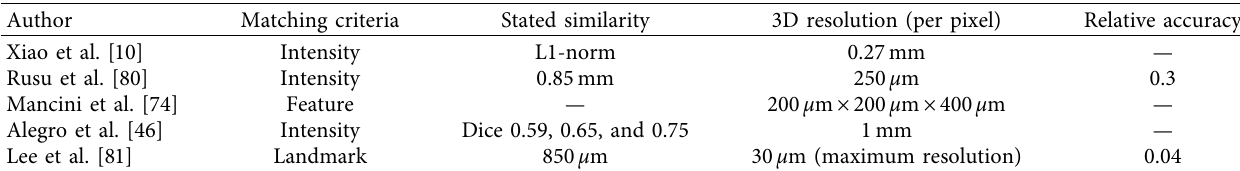
Table 3: List of volume-to-volume registration strategies discussed in this review. Due to a lack of information, a direct comparison according to the relative accuracy was not possible since only Rusu et al. [80] and Lee et al. [81] provided sufcient data. Terefore, there can be no quantitative